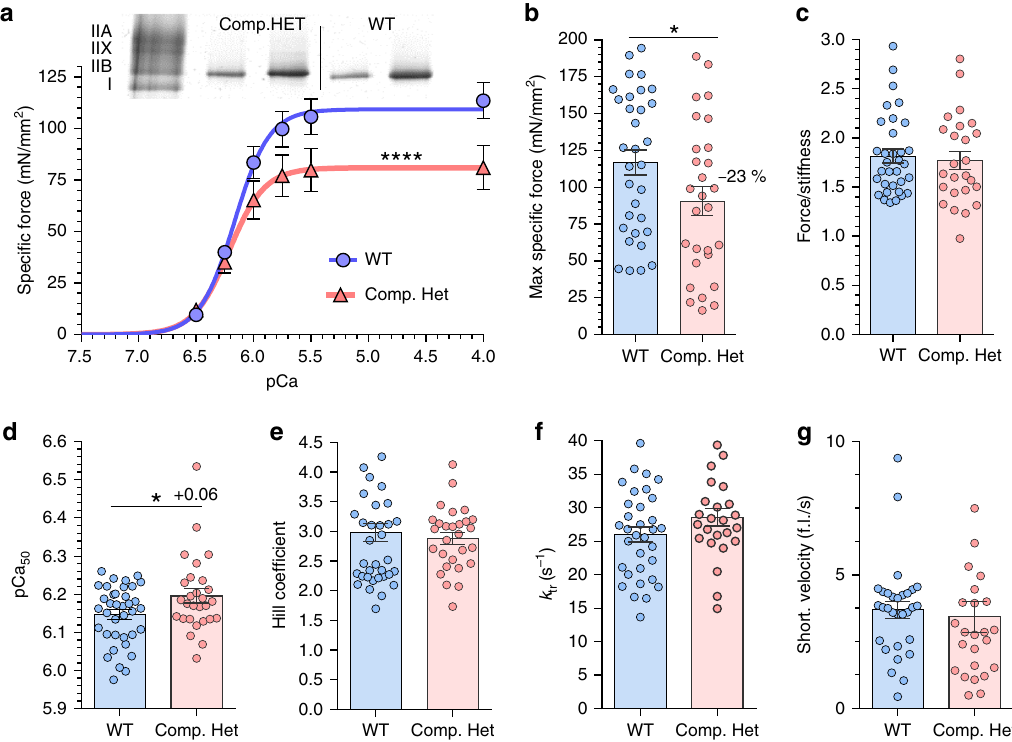
Fig. 7 Single fi ber mechanics in type IIB fi bers (EDL muscle) of Compound-Het mice. a Top: MHC-gel. Examples of IIB single fi bers that were used in experiment. Two Compound-Het and two WT fi bers are shown and a total of 41 WT and 40 Compound-Het fi bers were studied; (WT: 34/41 fi bers were IIB; Compound-Het: 28/40 fi bers were IIB). The left lane is a standard with all MHC isoforms. a Bottom: Speci fi c force – pCa relations of Compound-Het and WT fi bers. A Hill-type curve- fi t analysis shows that the Compound-Het fi bers are signi fi cantly different from WT fi bers. b Maximal speci fi c force is reduced in Compound-Het fi bers ( p = 0.046). c The force/stiffness relation is unaltered. Increase in calcium sensitivity ( p = 0.028) ( d ) but unchanged cooperativity ( e ) in Compound-Het fi bers. (Values based on force-pCa curves that were normalized to the maximal speci fi c force.) Kinetics of tension redevelopment as re fl ected in k tr ( f ) and maximal shortening velocity ( g ) are unaltered in Compound-Het fi bers. The data set comprises on average 7 type IIB fi bers from each of 5 WT mice and 5 type IIB fi bers from each of 6 Compound-HET mice. Values are mean ± SEM. a : allosteric sigmoidal non-linear least squares fi t with as null hypothesis that one curve fi ts all data sets. Test (Sum-of-squares F-test) reveals that the null hypothesis is rejected ( p ≤ 0.0001, F (DFn, DFd) 8.146 (3,360)). b – g two-tailed unpaired t-test. * p < 0.05; **** p < 0.0001. Source data are provided as a Source Data fi